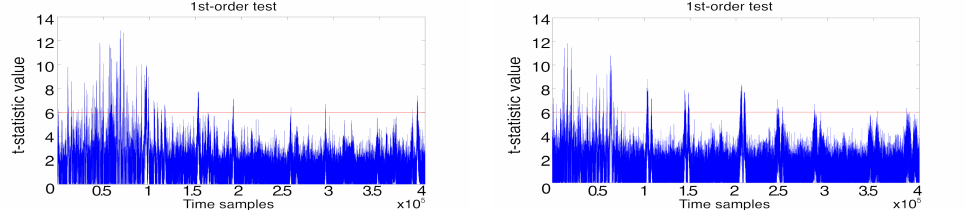
Figure 7: rdm_point () random vs fixed scalar